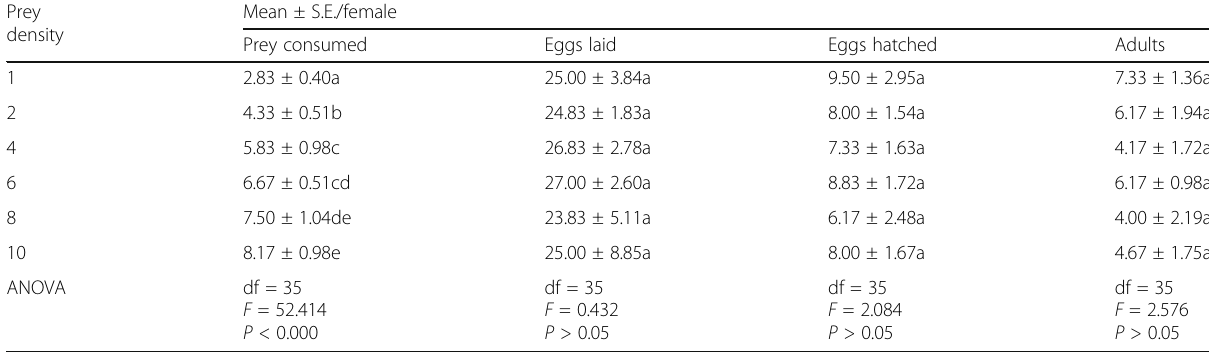
Table 5 Numerical response of predator A. biannulipes feeding on P. truncatus larvae at various densities Prey